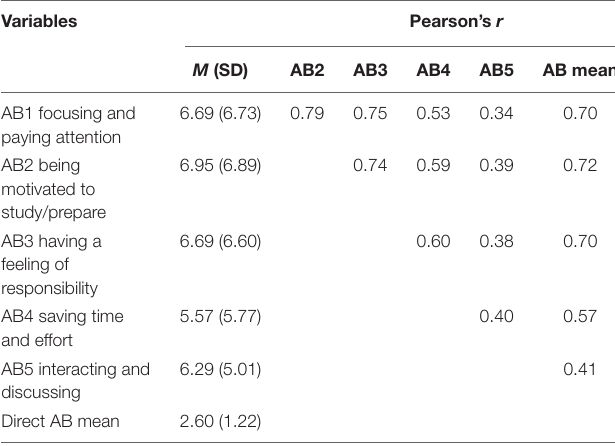
TABLE 5 | Descriptive statistics and correlations of attitude toward behavior (AB) for OLL group ( n = 287).